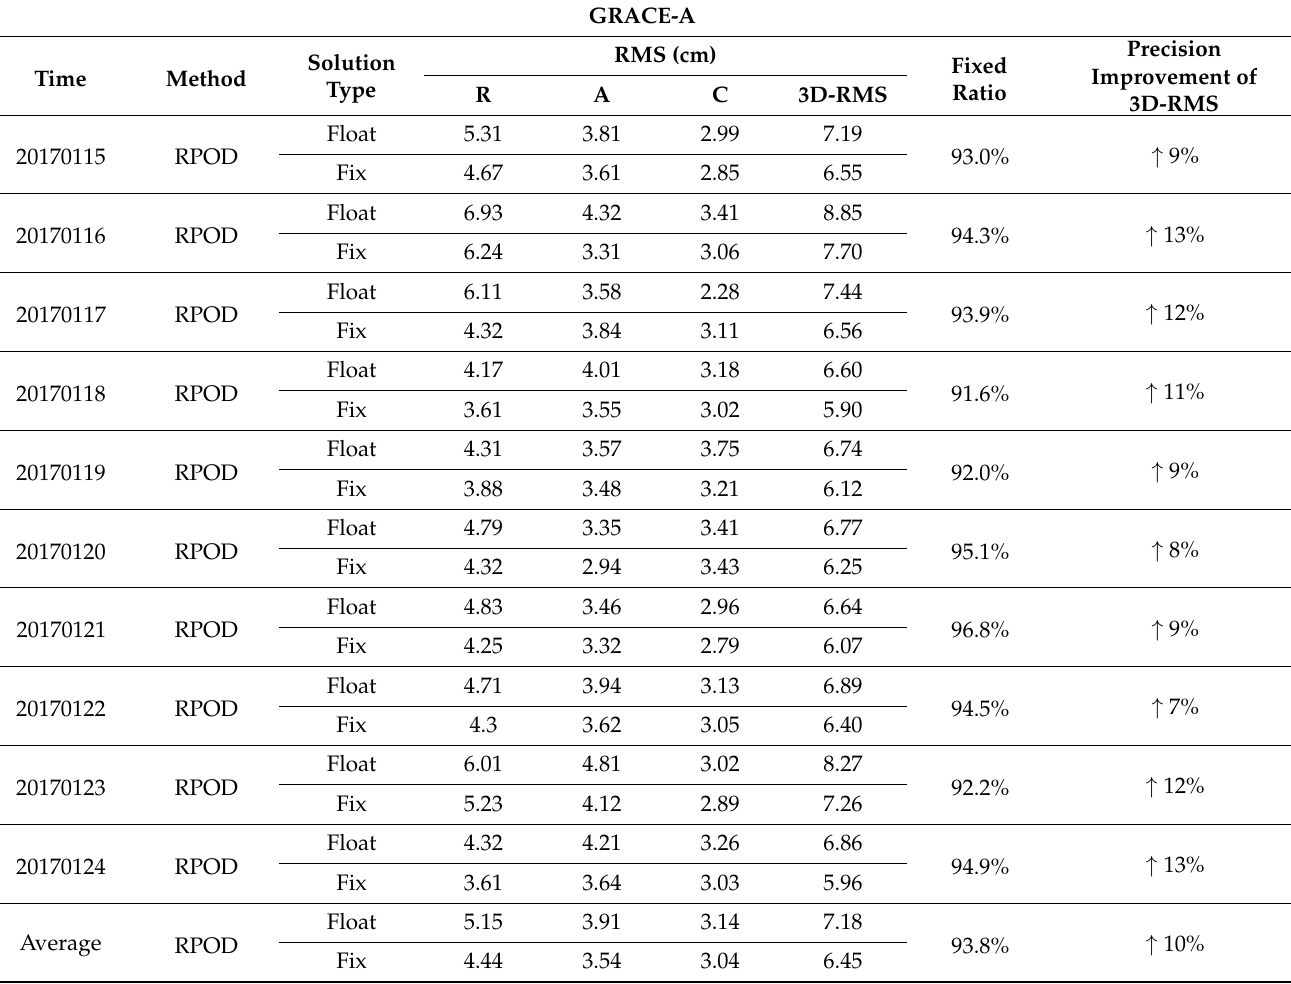
Table 6. The GRACE-A ambiguity-fixed ratio and RMS of real-time RPOD in R (radial), A (along- track), and C (cross-track) directions and 3D-RMS (total position error) with different solution